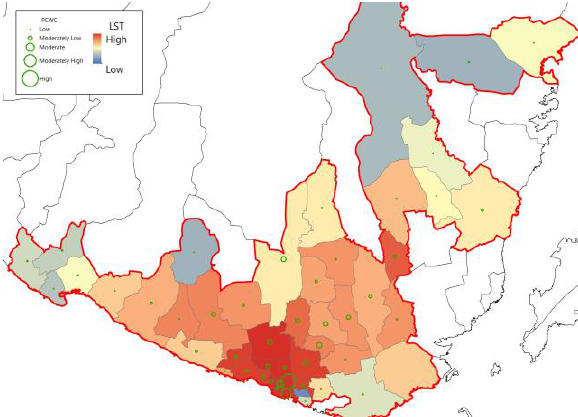
Figure 4. Spatial variation of barangay-averaged LST and PCWC data of the 49 barangays for April 2016